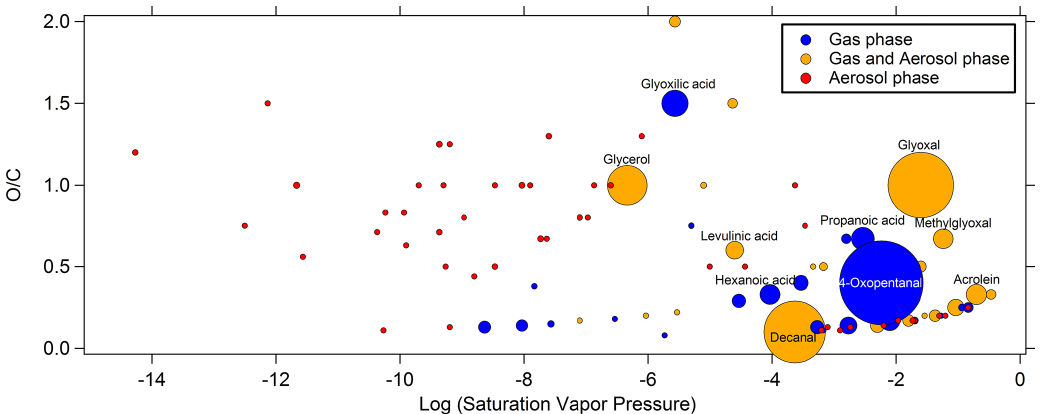
Figure 3. Distribution of compounds identified by TD–GC–MS during the ChArMEx campaign according to the logarithm of their saturation vapor pressure (horizontal axis) and of their O / C ratio (vertical axis). The phase in which they are detected is color-coded: blue for compounds only detected in the gas phase, red for aerosol phase only and orange for compounds detected in both phases. Each dot represents a single compound, and the dot area is proportional to the sum of concentrations if detected in both phases from 0.3ngm − 3 for the smallest dot to 3.9µgm − 3 for the biggest one. The names of some noticeable compounds are also